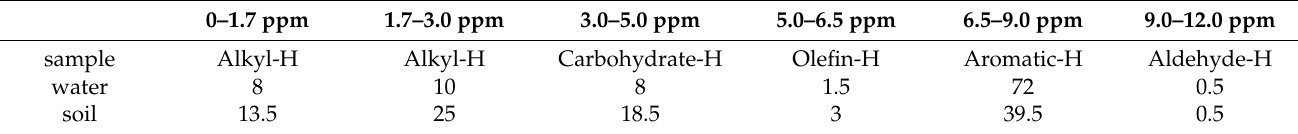
Table 3. Proton distribution (%) estimated from the integration of 1 H NMR spectra [38].